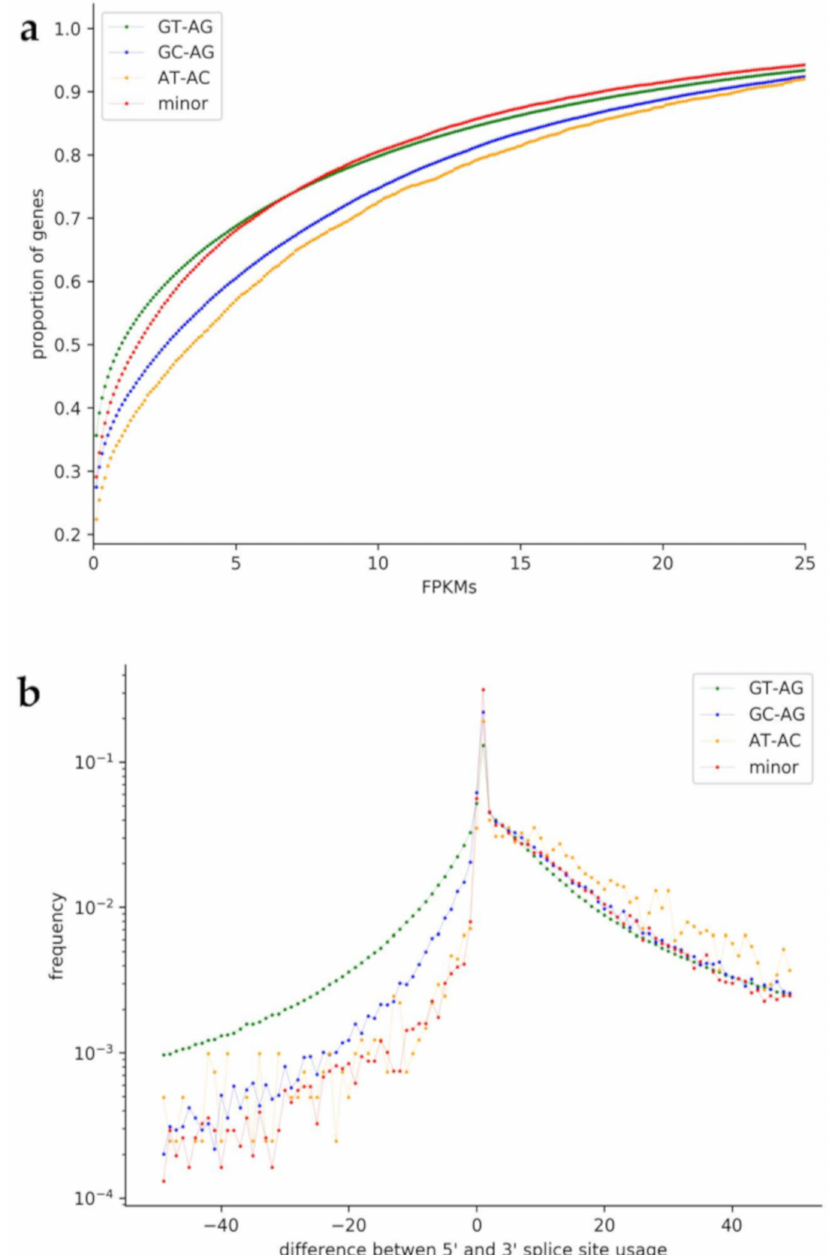
Figure 4. Usage of non-canonical splice site combinations in plant species. ( a ) Comparison of the transcript abundance (FPKMs) of genes with non-canonical splice site combinations to genes with only canonical GT-AG splice site combinations. GC-AG and AT-AC containing genes display especially low proportions of genes with low FPKMs. ( b ) Comparison of the usage of 5 (cid:48) and 3 (cid:48) splice sites. On the x-axis, the di ff erence between the 5 (cid:48) splice site usage and the usage of the 3 (cid:48) splice site is shown. A fast drop of values when going to the negative side of the x-axis indicates that the 3 (cid:48) splice site is probably more flexible than the 5 (cid:48) splice